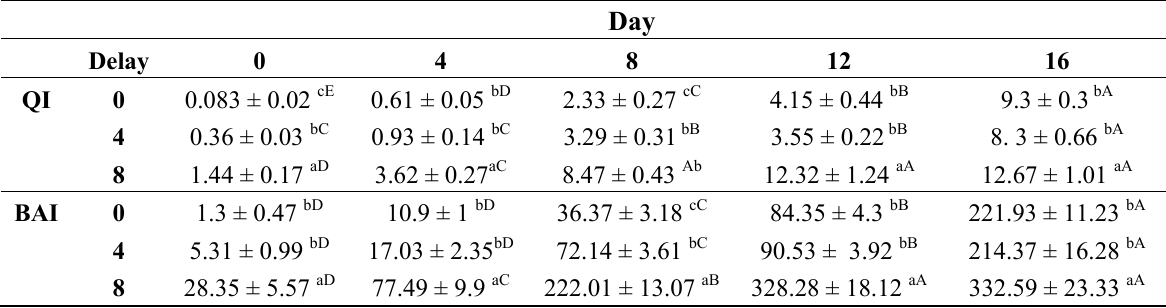
Table 2. Quality and biogenic amine indexes of common carp stored in ice with 0, 4 and 8 h delay before